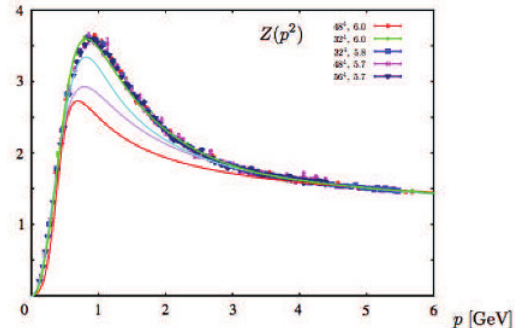
Fig. 1. The Landau gauge gluon renormalization function ob- tained from di ff erent calculations, see text for